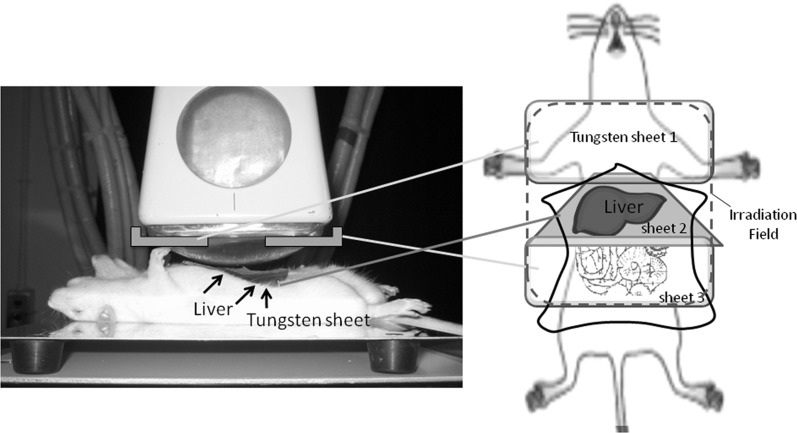
Schema for the whole-liver irradiation technique used in this study.